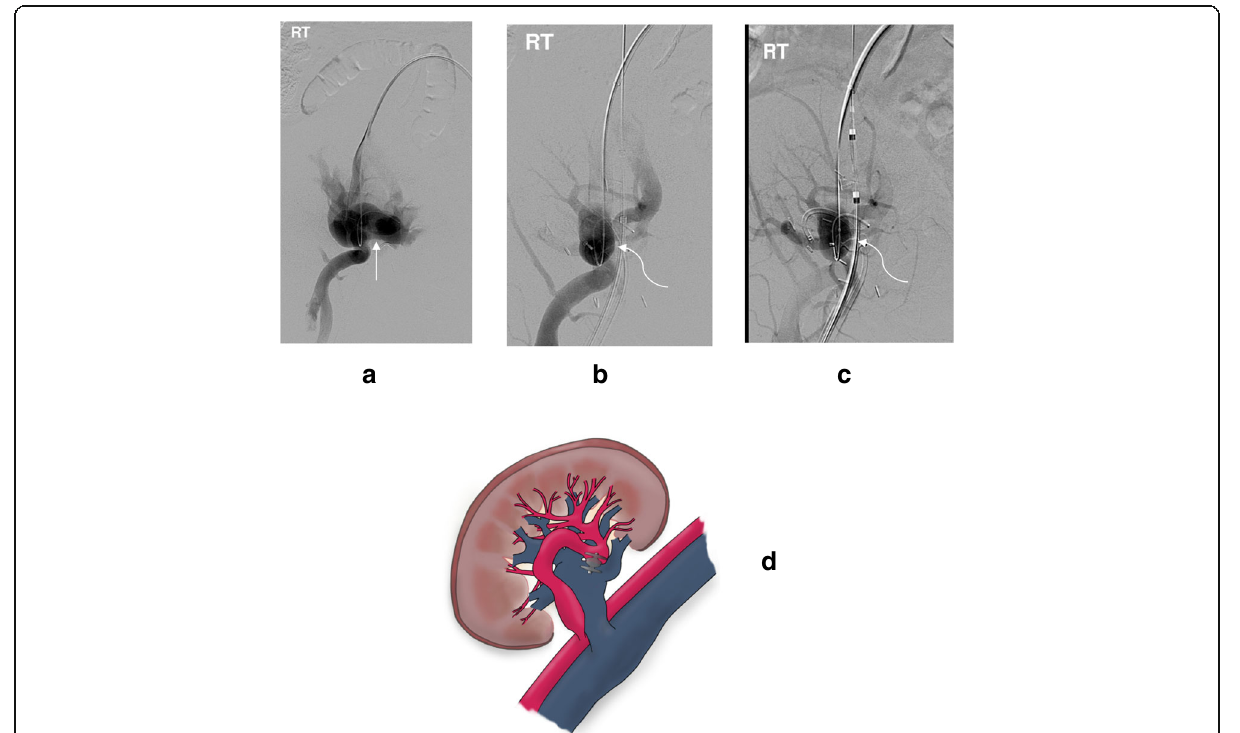
Fig. 4 Angiographic demonstration of successful embolisation of AVF. The AVF (white arrow) demonstrated pre ( a ) and post ( b & c ) successful Amplatzer plug (curved arrow) occlusion, with no filling of the fistula. d Schematic diagram confirming Amplatzer plug occlusion of the AVF with no through flow